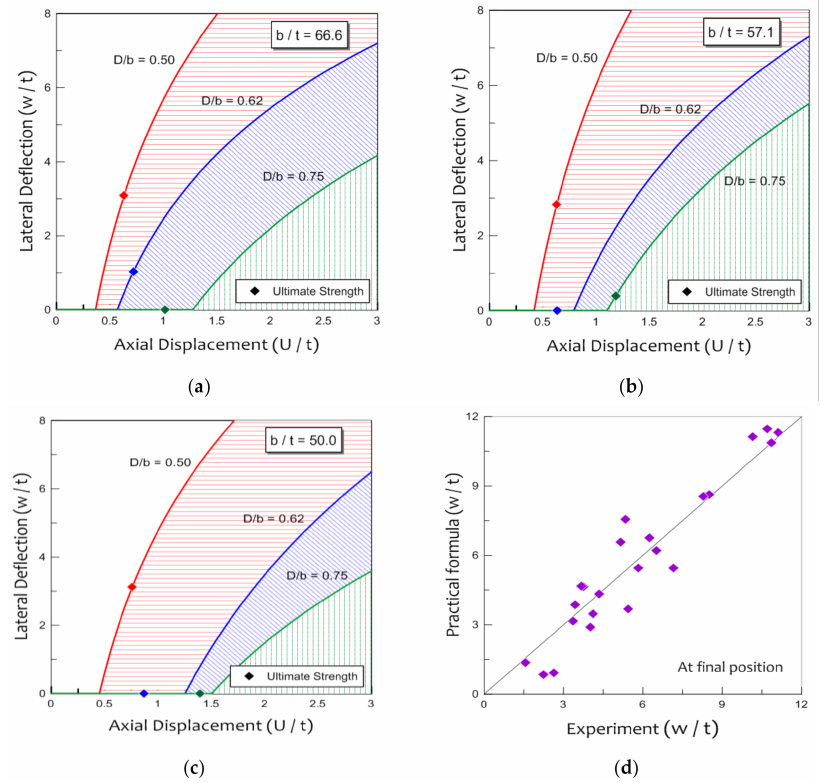
Figure 13. Practical curves for estimating lateral deflection of perforated plates: ( a ) 66.6 (b/t), ( b ) 57.1 (b/t), and ( c ) 50.0 (b/t) and ( d ) correlations between lateral deflection results from experiment and practical